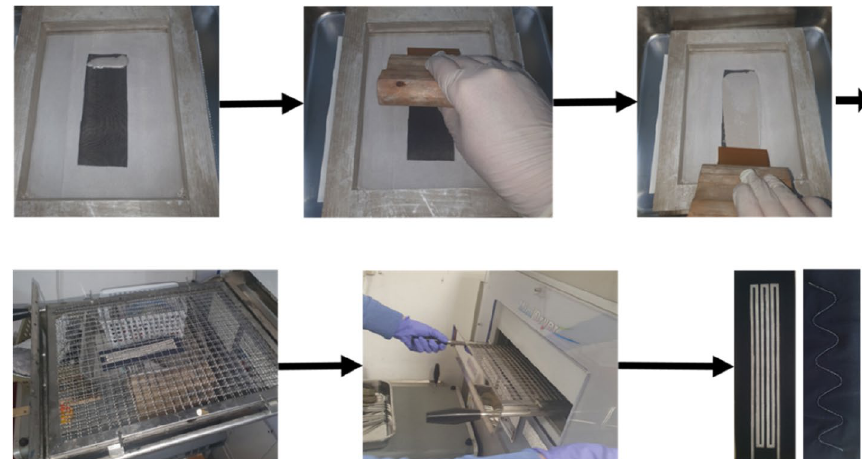
Fig. 2 Screen printing silver-past layer